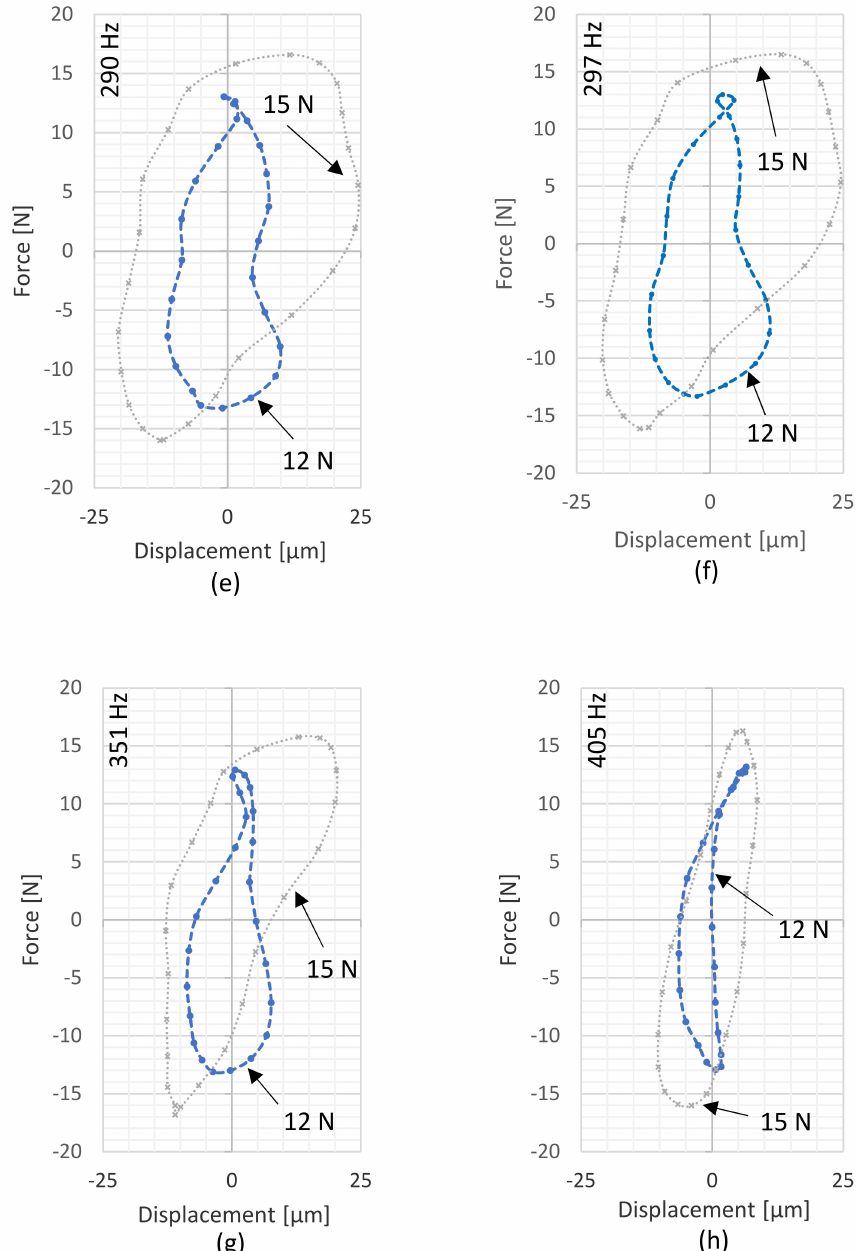
Figure 6. Averaged hysteresis curves (xx-direction) showing the dependency of force (ca. 11.1 N static load) from 147 Hz to 405 Hz ( a – h